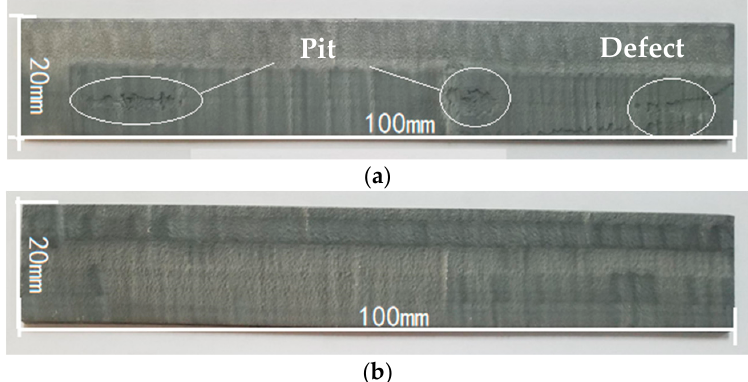
Figure 2. Surface characteristics of the Zn 65 Al 15 Mg 5 ZnO 15 ( a ) and Zn 45 Al 35 Mg 5 ZnO 15 ( b ) composite coatings taken with an optical camera.